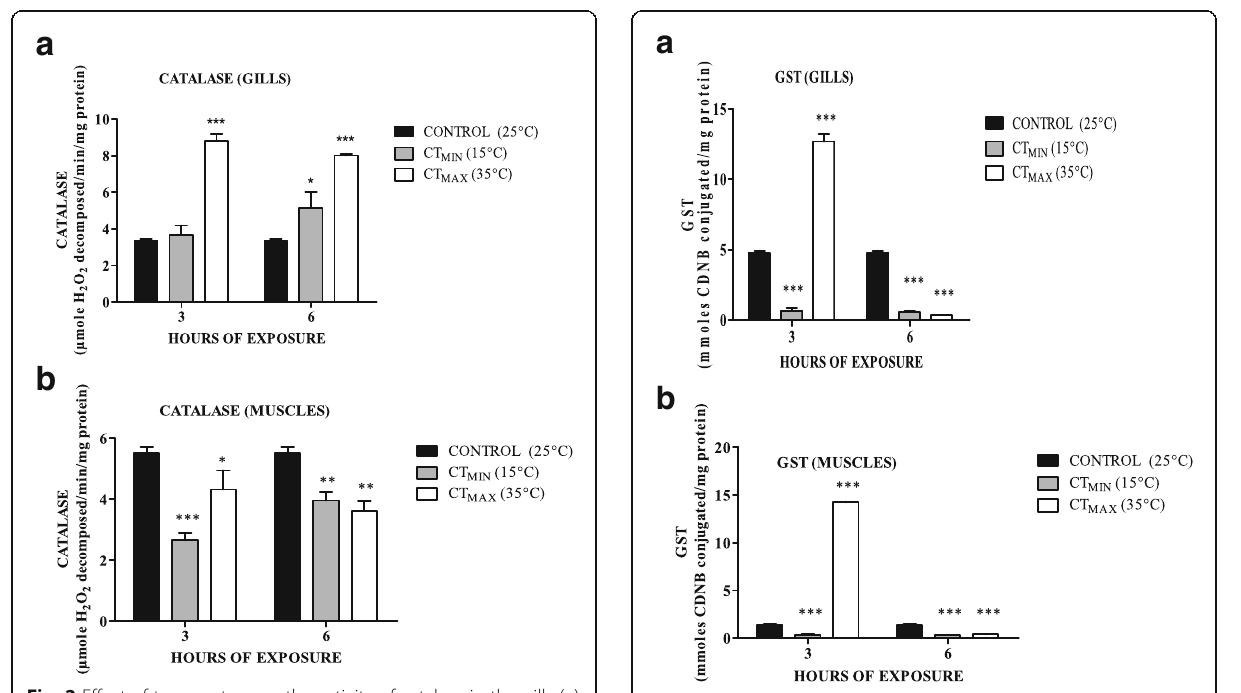
Fig. 3 Effect of temperature on the activity of GST in the gills ( a ) and muscles ( b ) of Koi carps. Significance was calculated by two- way ANOVA followed by Bonferroni post-test where p < 0.001 (***). The vertical lines indicate mean ± SE. Bars represent different periods of